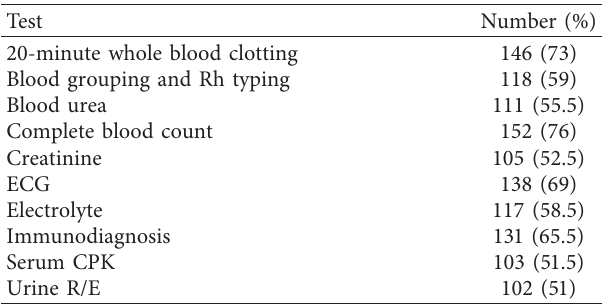
Table 5: Percentages of nursing students who acknowledged the necessity of certain laboratory tests following a